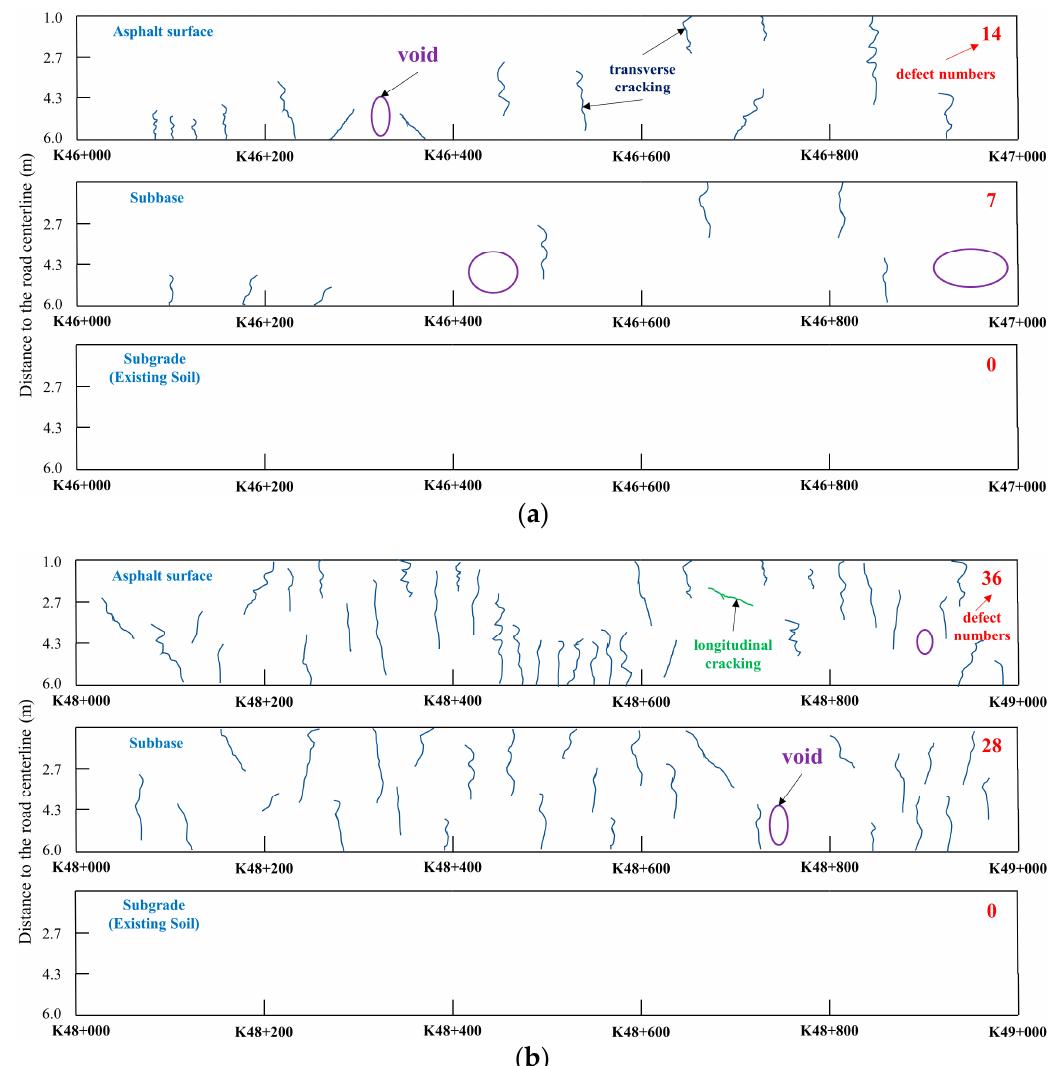
Figure 9. A schematic for detection results of partial tested road. ( a ) General defect severity and ( b ) high defect severity.